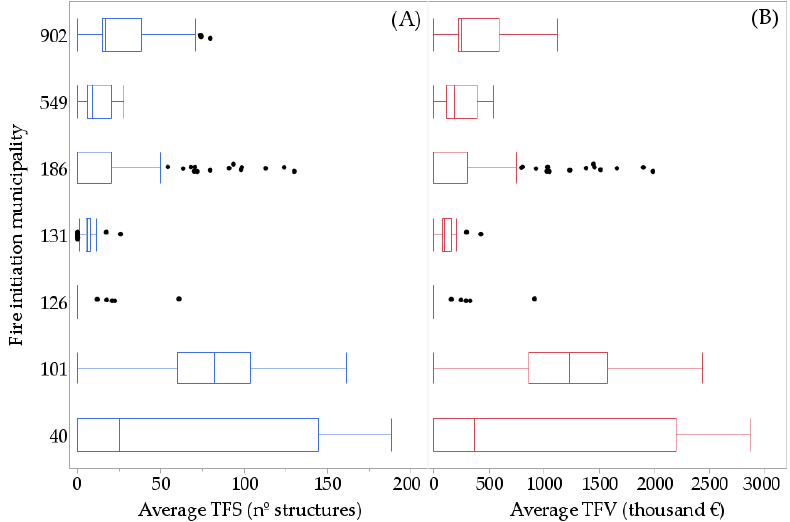
Figure 6. Box plots of average wildfire transmission into the study area from independent ignitions in surrounding municipalities (Figure 1A), in terms of ( A ) number of residential houses and ( B ) cadaster economic value of residential houses affected. For every fire ignition, the number of affected structures and the sum of their economic value was calculated combining the results obtained in the five modeling scenarios (Table 2). Boxes indicate the first/third quartiles, the whiskers indicate 10th/90th percentiles, the black line within the box is the median, and the dots indicate values below the 10th percentile or above the 90th percentile. The municipalities are identified with the cadaster code (Figure